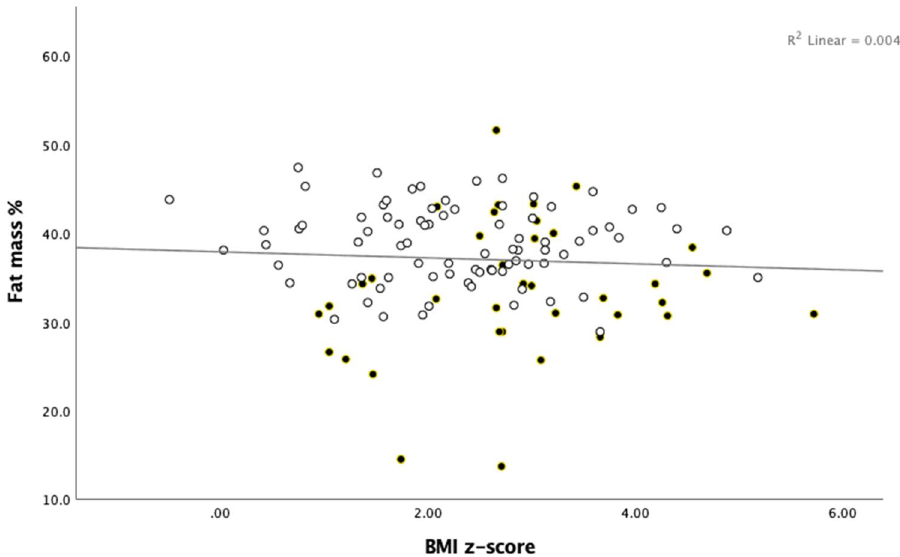
Figure 2. The relationship between DXA-based fat mass percentage and BMI z-score. DXA dual-energy X-ray absorptiometry, BMI body mass index. Clear circles=female, filled circles=male